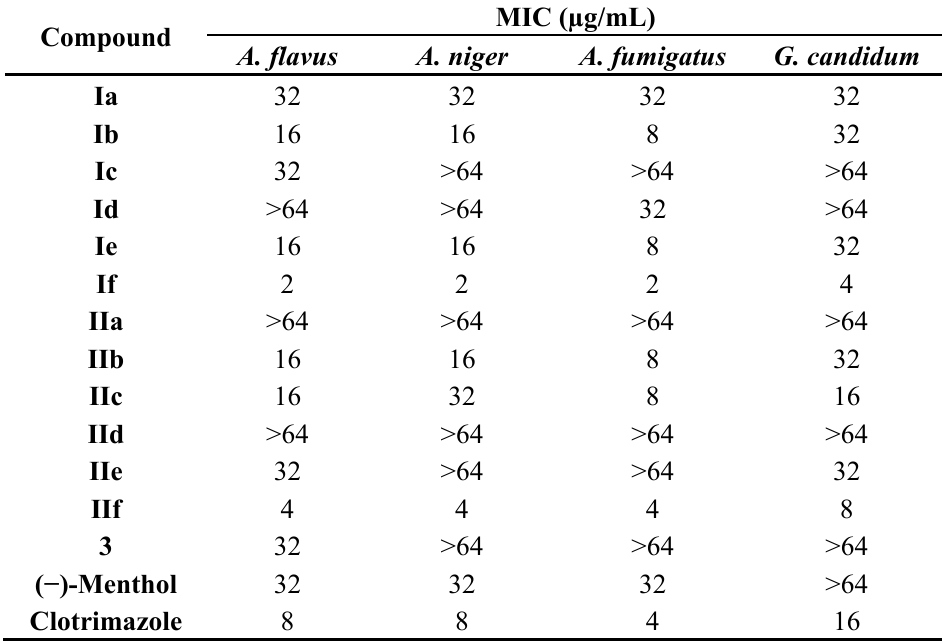
Table 2. MIC data (µg/mL) of the tested compounds against selected fungal strains.